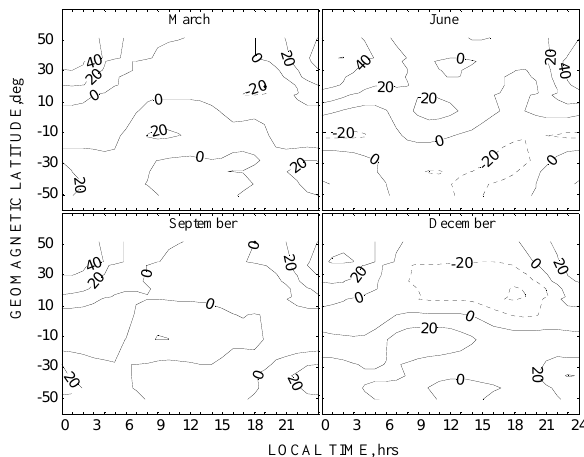
Fig. 7. The empirical equivalent winds ( EEWs ) at solar minimum estimated from the HWM93 model and the empirical electric field drift model by Scherliess and Fejer (1999). Positive upward.